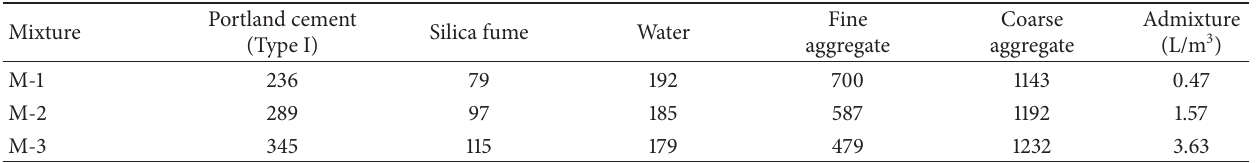
Table 2: Concrete mix proportions (kg/m 3 ).